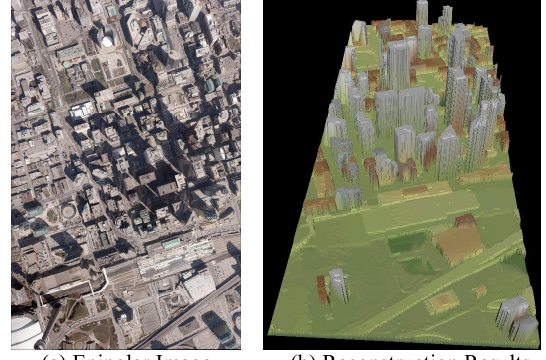
Figure 8. Reconstruction of